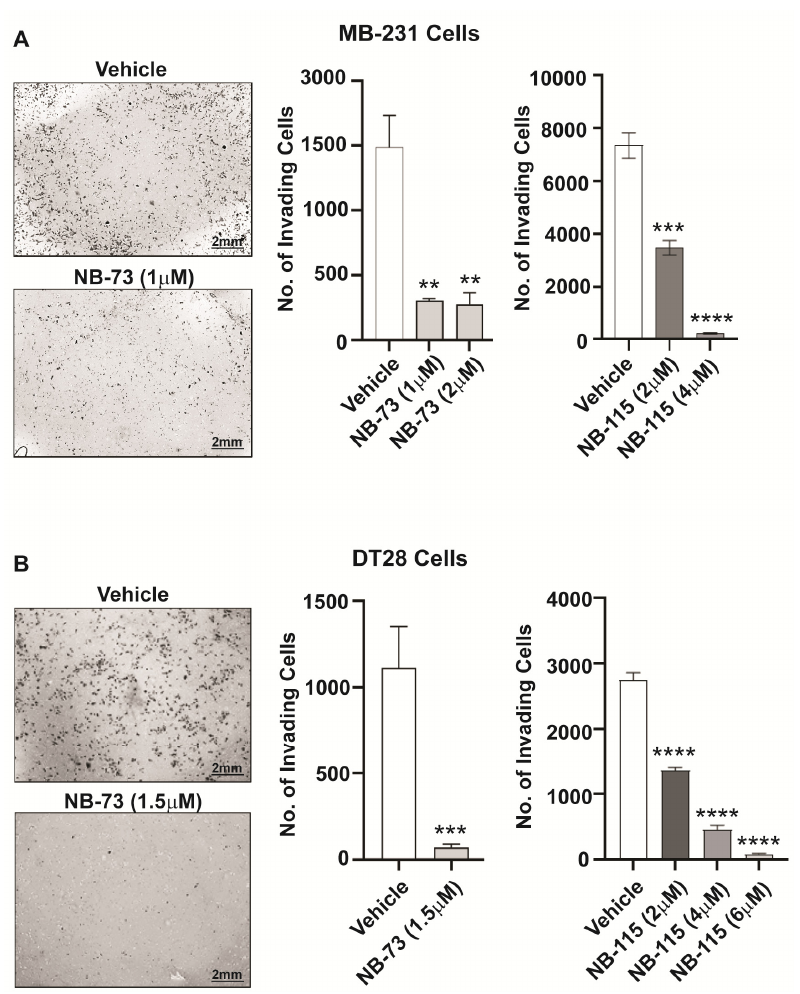
Figure 2. FOXM1 inhibitory compounds reduce invasive potential of TNBC cells, ( A ) MDA-MB-231 cells and ( B ) DT28 cells were treated for 48h with NB-73 or NB-115 and were monitored for invasion using Matrigel-coated cell culture inserts in 24-well plates. At left, a few representative images of cell fields viewed microscopically are shown. Statistical analysis of data shown at right used one-way ANOVA and * p < 0.05, ** p < 0.01 and *** p < 0.001 are indicated; mean ± SD.